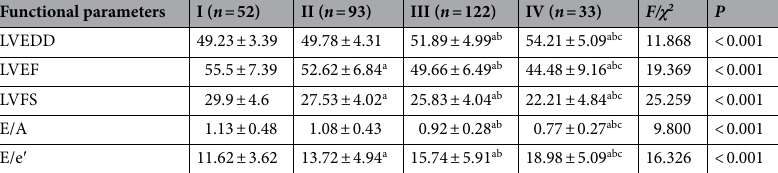
Table 3. Cardiac function related parameters. a vs. Grade I, b vs. Grade II, c vs. Grade III, P < 0.05. LVEDD left ventricular end-diastolic dimension, LVEF left ventricular ejection fraction, LVFS left ventricular short-axis fractional shortening, A late diastolic, E early diastolic, E/e ′ early mitral inflow velocity to mitral early diastolic velocity ratio.